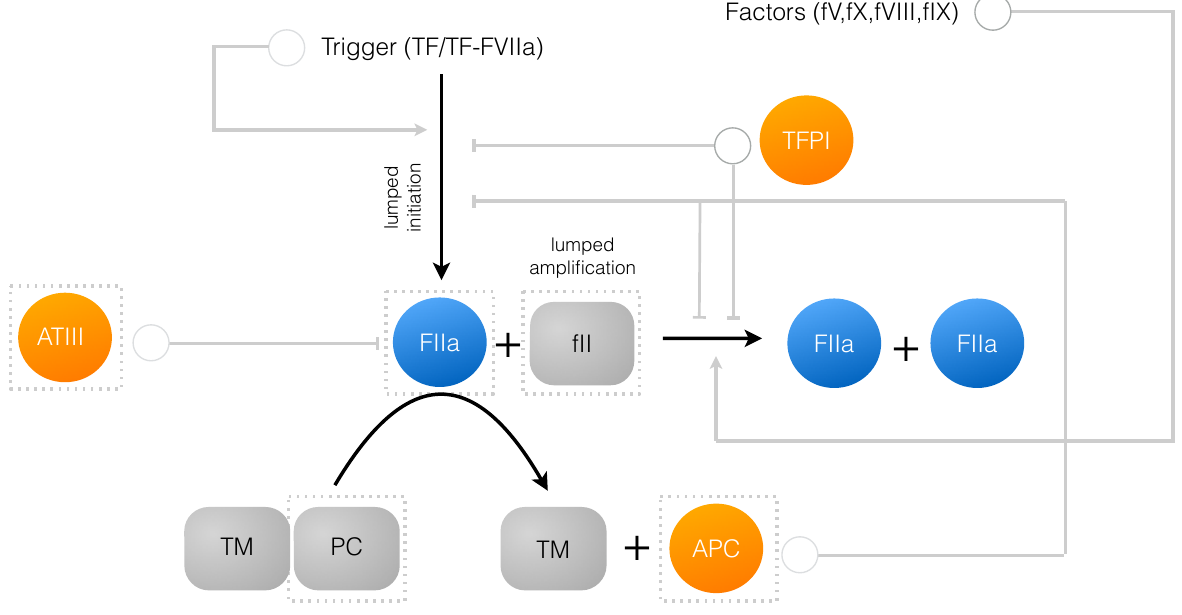
Figure 1. Schematic of the connectivity of the reduced order coagulation model. A trigger compound, e.g., TF/FVIIa initiates thrombin production (FIIa) from prothrombin (fII). Once activated, thrombin catalyzes its own activation (amplification step), as well as its own inhibition via the conversion of protein C to activated protein C (APC). APC and tissue factor pathway inhibitor (TFPI) inhibit initiation and amplification, while antithrombin III (ATIII) directly inhibits thrombin. All inhibition steps and trigger-induced initiation were modeled using a rule-based approach. Likewise, the dependence of amplification on other coagulation factors was also modeled using a rule-based approach. The abundance of the highlighted species (in the dashed boxes) was governed by an ordinary differential equation. All other species were assumed to be